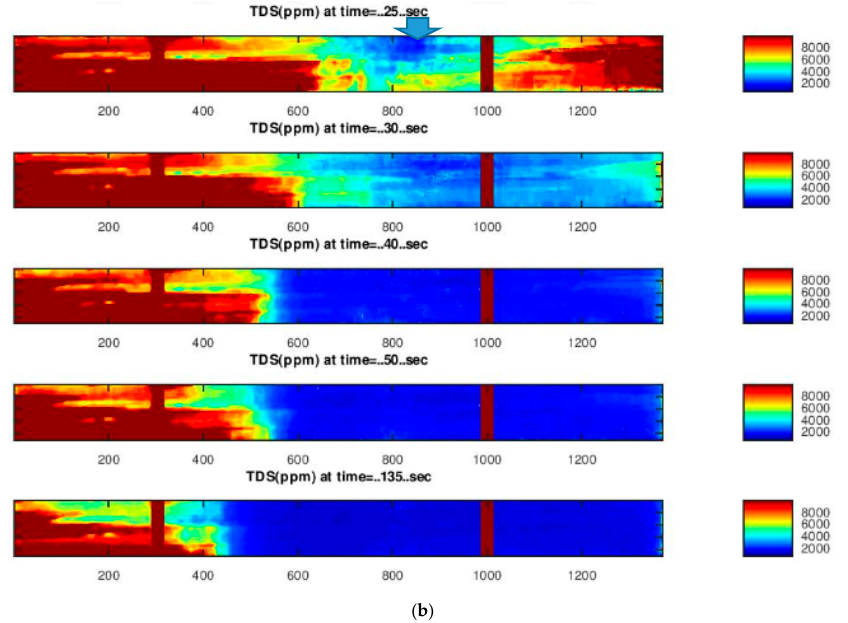
Figure 7. ( a )Temporal Reduction of TDS (Run #15, Xp/D = 7) and ( b ) color maps for TDS variation with the course of time (Run #15, Xp/D = 7).